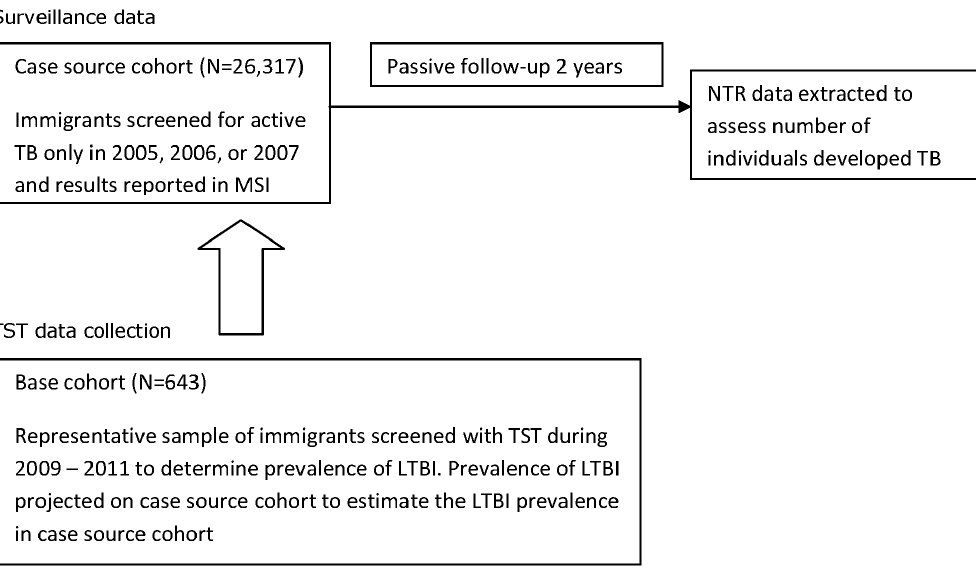
Figure 1. Schematic overview of study design.